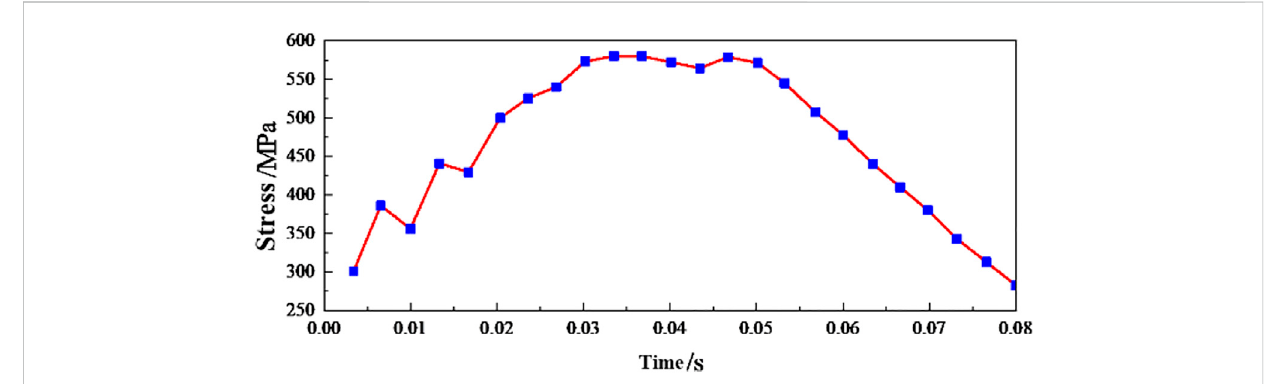
FIGURE 7 Top beam stress change